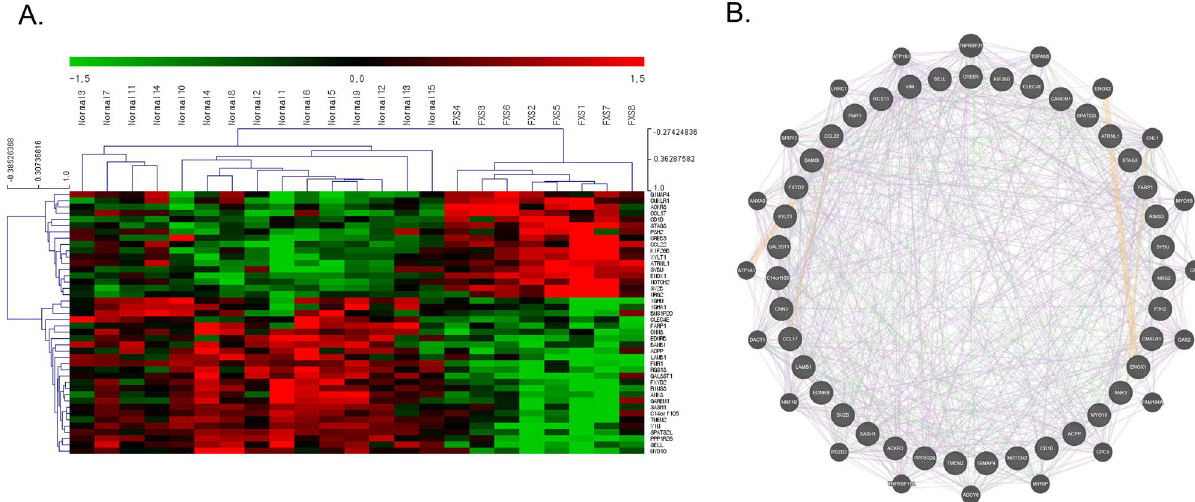
Figure 1. 42 genes were selected as DEGs between FXS and healthy control from GSE7329 data. ( A ) Heatmap of DEGs. ( B ) Molecular relationship between DEGs and associated genes. DEGs are located at the inner circle, associated are at outer. The color of the edge represents co-expression (purple), shared protein domain (grey), genetic interaction (green), predicted association